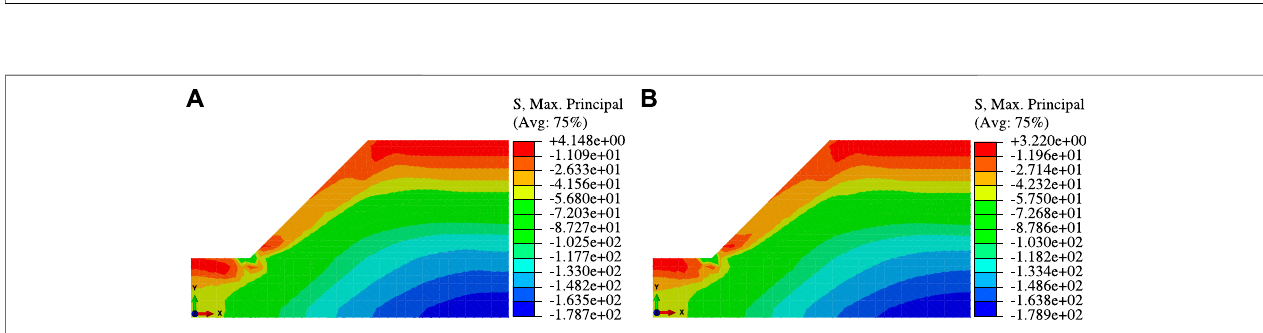
FIGURE 14 | Maximum principal stress nephograms of unstable slopes: (A) M-C yield criterion and (B) tension-shear and compression-shear joint yield criterion.